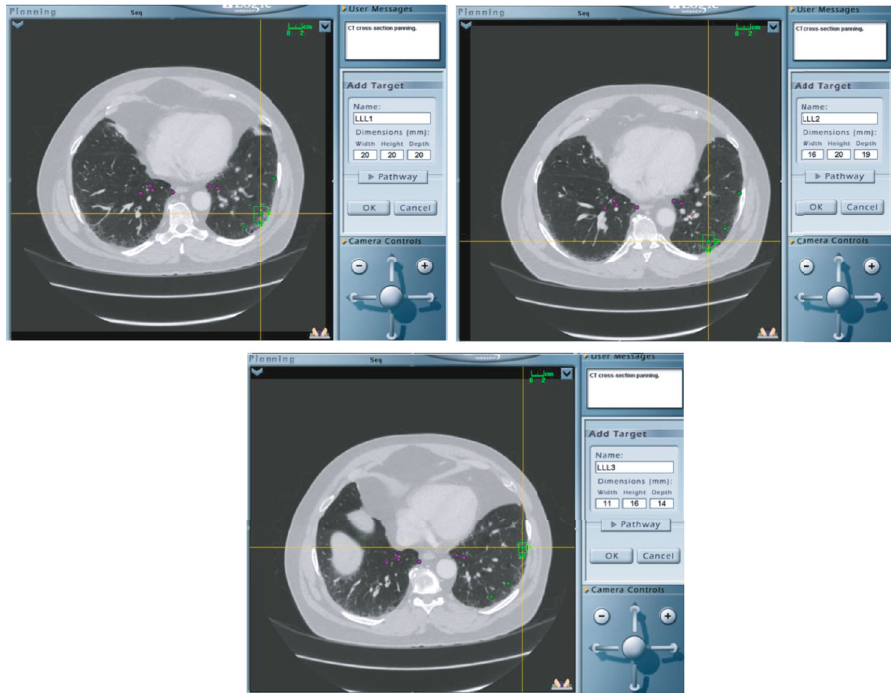
Figure 2: Preprocedure mapping for case 1 using the Medtronic superDimension Navigation System, version 7, Minneapolis, USA. Three targets were premarked in the left lower lobe